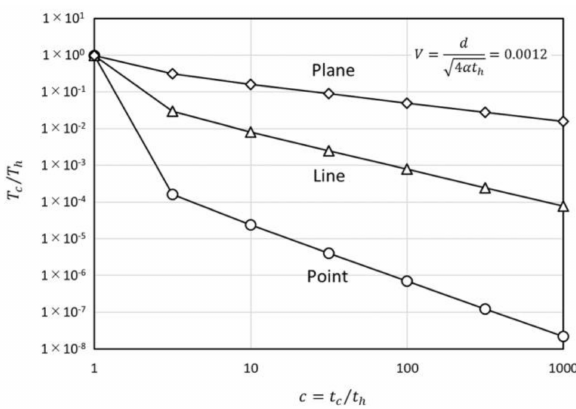
√ 3/2, (cid:16) √ (cid:17) − 3/2 10